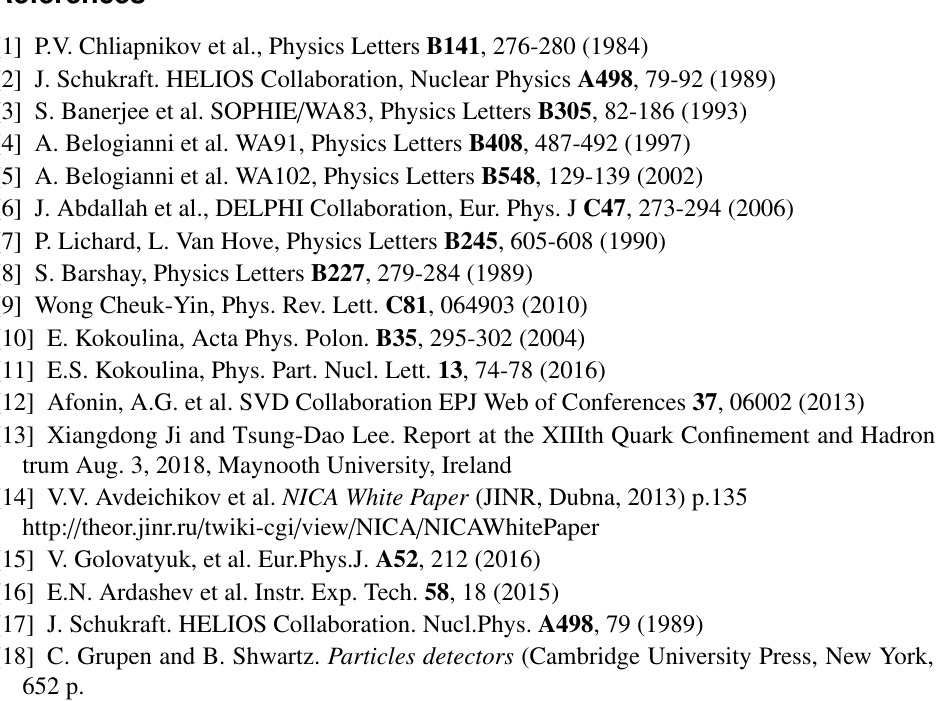
to the SVD-2 Collaboration for the fruitful work in the manufacture of SpaCal, getting and discussing the main